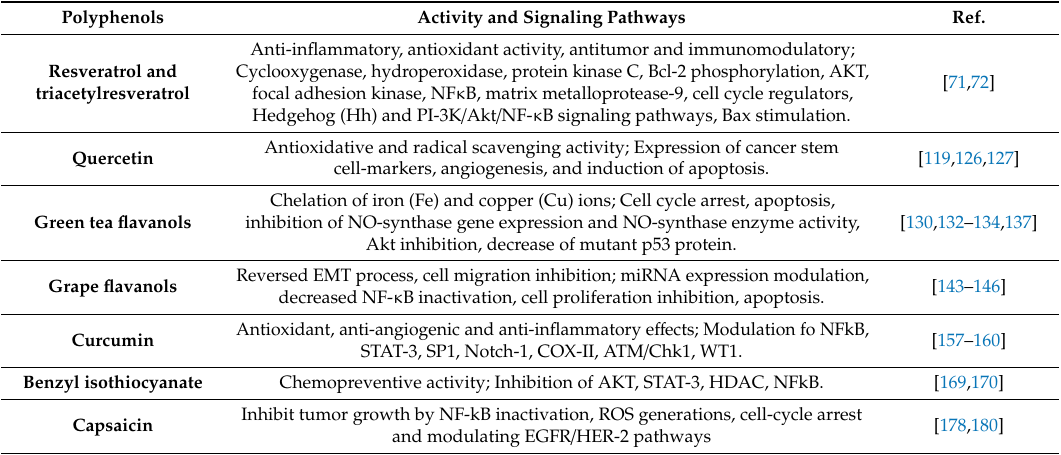
Table 1. Positive health activity of selected polyphenols and target / signaling pathways involved in PC.